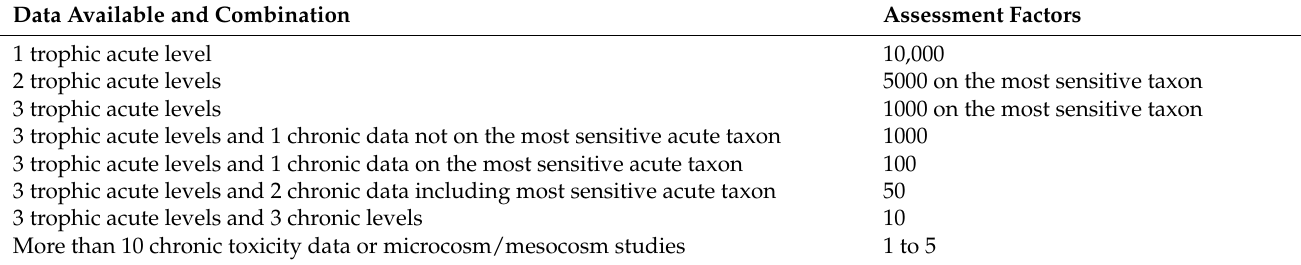
Table 6. Possible data combinations and application factors for Predicted No effect Concentration (PNEC) derivation according to EnviroTox